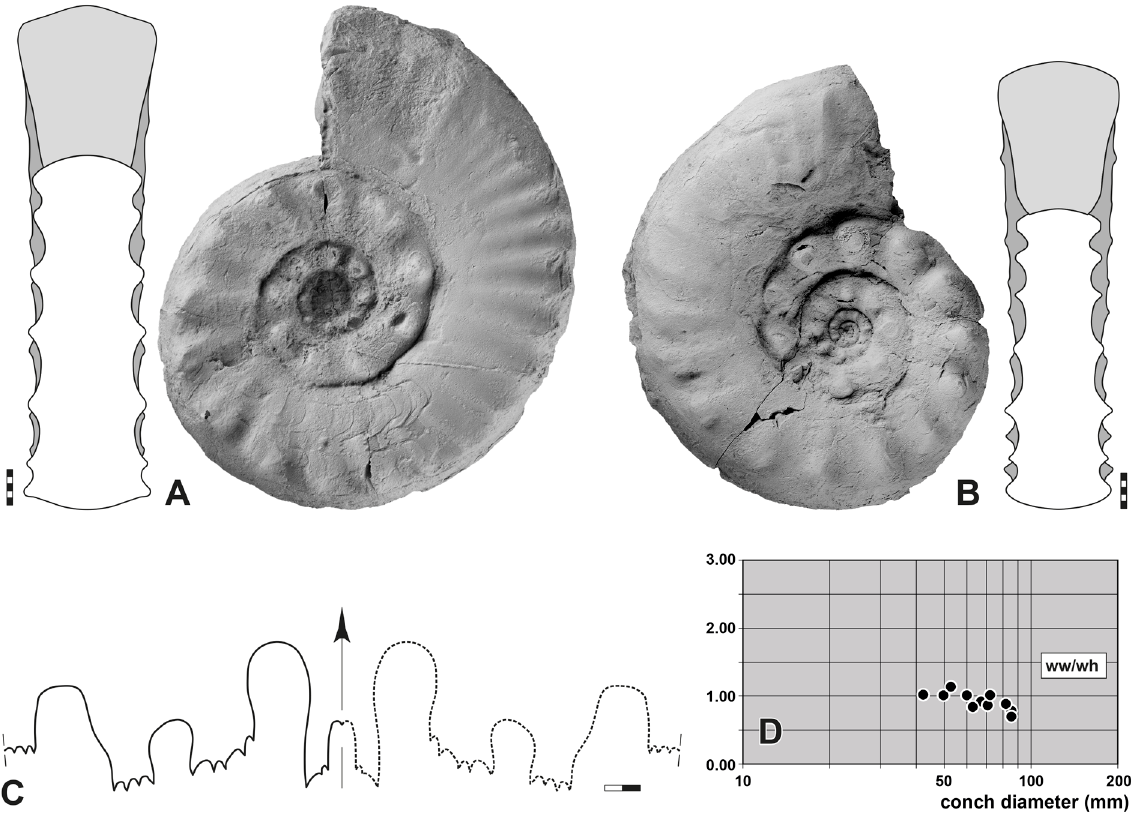
Fig. 33. Paratirolites baghukensis Korn & Hairapetian sp. nov. A–B . Lateral and dorsal views. A . Holotype MB.C.29868, section G, float. B . Paratype MB.C.29860, section E, -2.55 m. C . Suture line of holotype MB.C.29868, at 49.0 mm dm, 21.0 mm ww, 16.0 mm wh. D . Whorl profile proportions. Abbreviations: see Material and methods. Scale bar units = 1